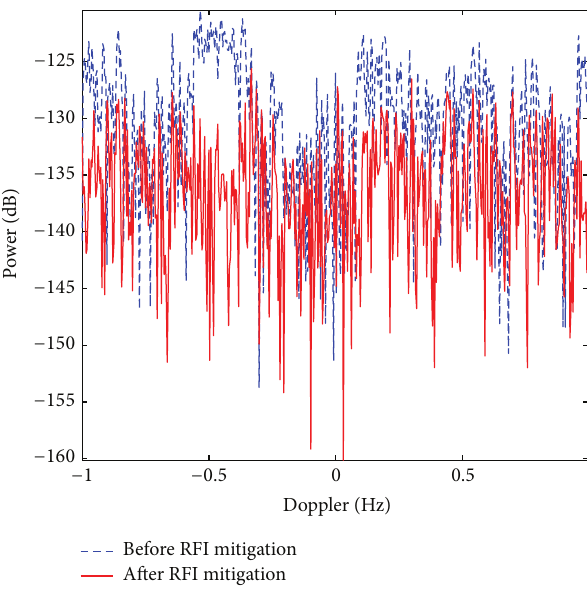
Figure 10: Range bin 40 cuts before and after RFI mitigation by the introduced